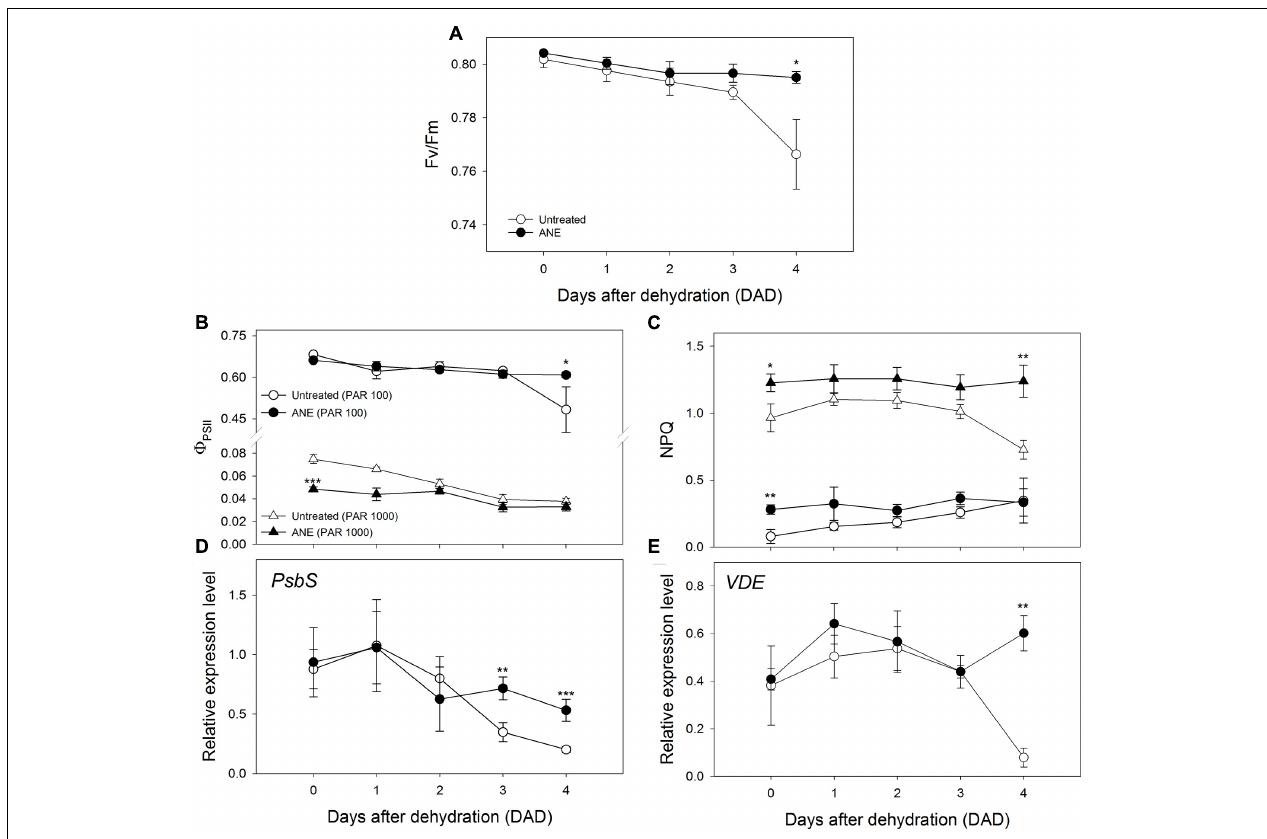
FIGURE 6 | Chlorophyll a fluorescence measurements and expression levels of genes related to photoprotection mechanisms at photosystem II. Time 0 is the dehydration stress starting time and it corresponds exactly with the last day of Ascophyllum nodosum extract (ANE) treatment. Potential efficiency of PSII photochemistry (Fv/Fm, A ), actual photon yield of PSII photochemistry in the light ( (cid:56) PSII, B ), non-photochemical quenching (NPQ, C ). (cid:56) PSII and NPQ were determined at photosynthetically active radiation (PAR) of 100 and 1000 µ mol m − 2 s − 1 . Each dot shows the mean ± SE of nine biological replicates. Expression pattern of PsbS (D) and VDE (E) during 5 days of dehydration (0–4 DAD). Each dot shows the mean ± SE of four biological replicates. Untreated (white dot) and ANE-treated (black dot) samples were analyzed by one-way ANOVA ( P < 0.05), ∗ P ≤ 0.05; ∗∗ P ≤ 0.01; ∗∗∗ P ≤